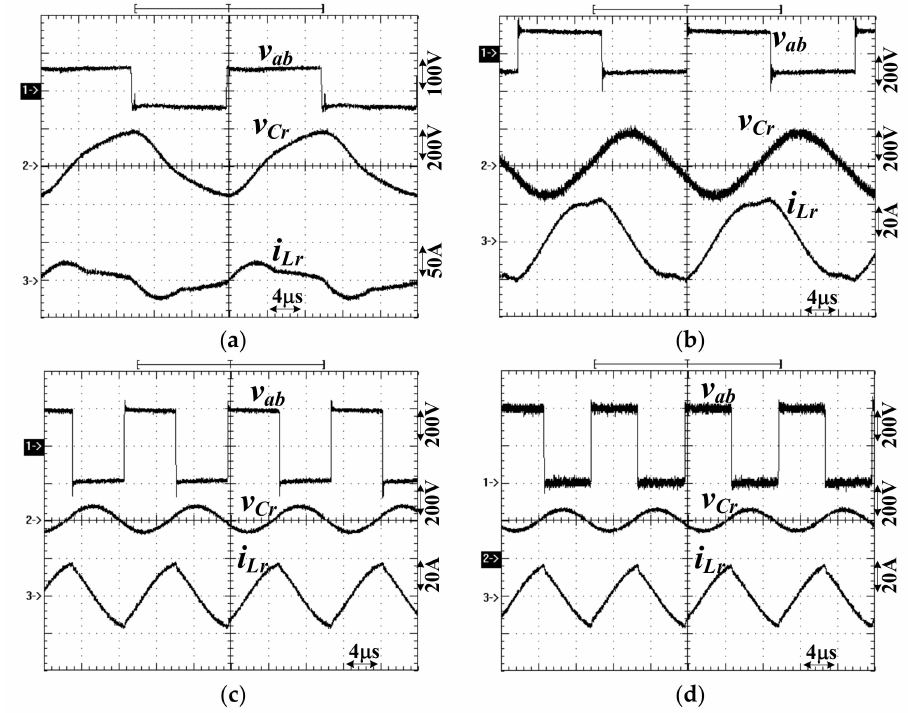
Figure 11. Measured primary-side voltage and current waveforms at 100% load: ( a ) 50 V input (low voltage range); ( b ) 110 V input (medium voltage range); ( c ) 190 V input (medium voltage range); ( d ) 400 V input (high voltage